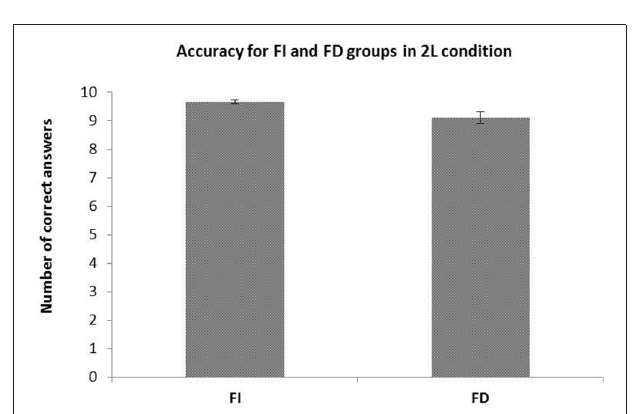
FIGURE 4 | Mean and S.E.M. of number of correct answers for Field Independent (FI) and Dependent (FD) groups in the recognition task with only two available landmarks. The FI group showed a higher accuracy.